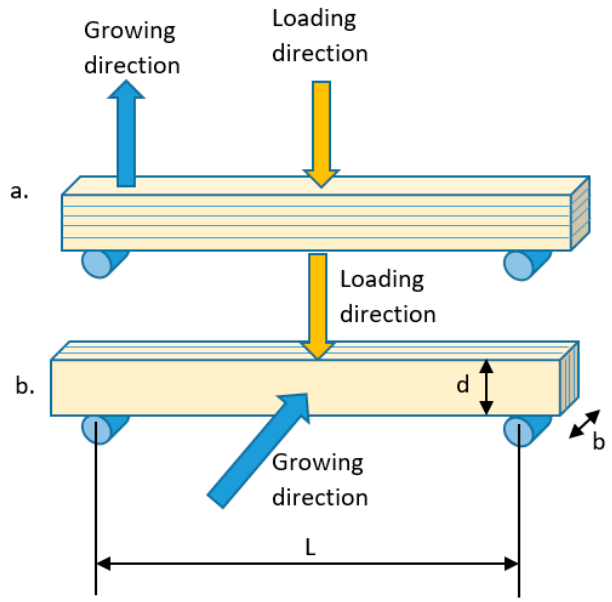
Figure 4. Loading directions ( a ) perpendicular to growing direction; ( b ) parallel to growing direction. b—specimen thickness, d—specimen depth, L—span between supports.